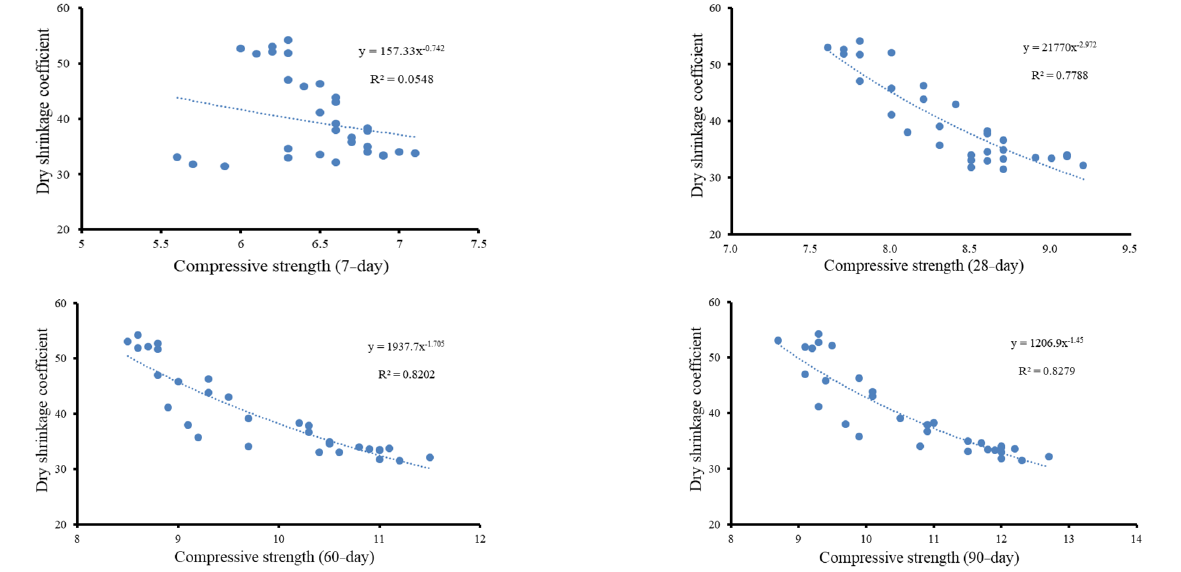
Figure 8. Relationships between compressive strengths and dry shrinkage coefficients.